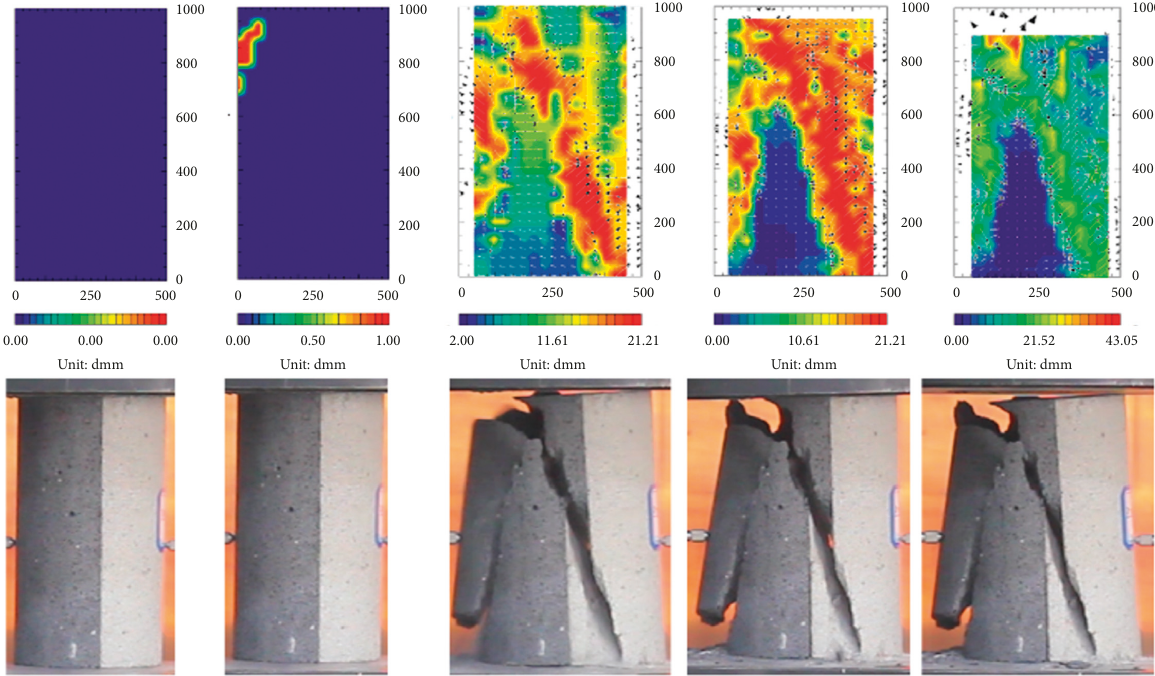
Figure 20: Coal pillar-artificial dam test failure